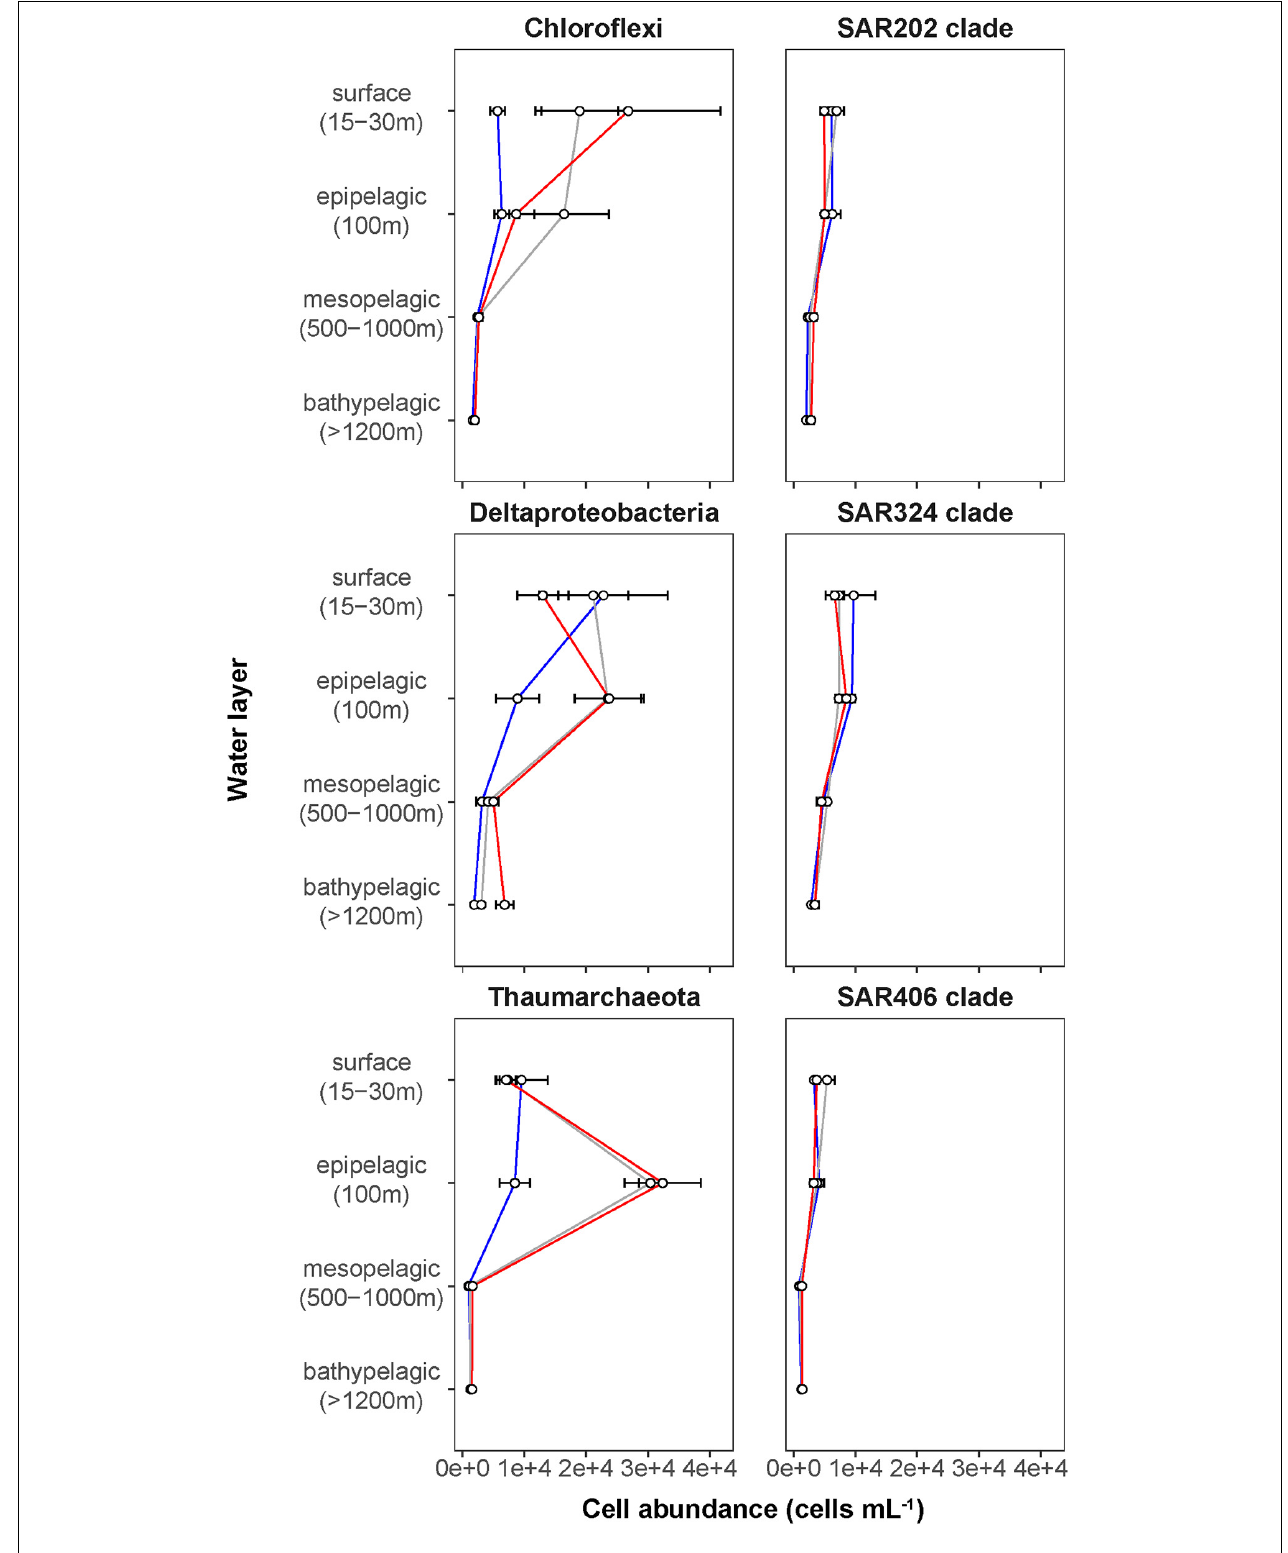
FIGURE 4 | Depth profiles of mean cell abundances of selected taxonomic groups (cells mL − 1 ) calculated for the different Fram Strait regions. The different regions are indicated by color: ice-covered EGC–blue (EG stations), ice-margin N–gray (N stations), ice-free WSC–red (HG stations).